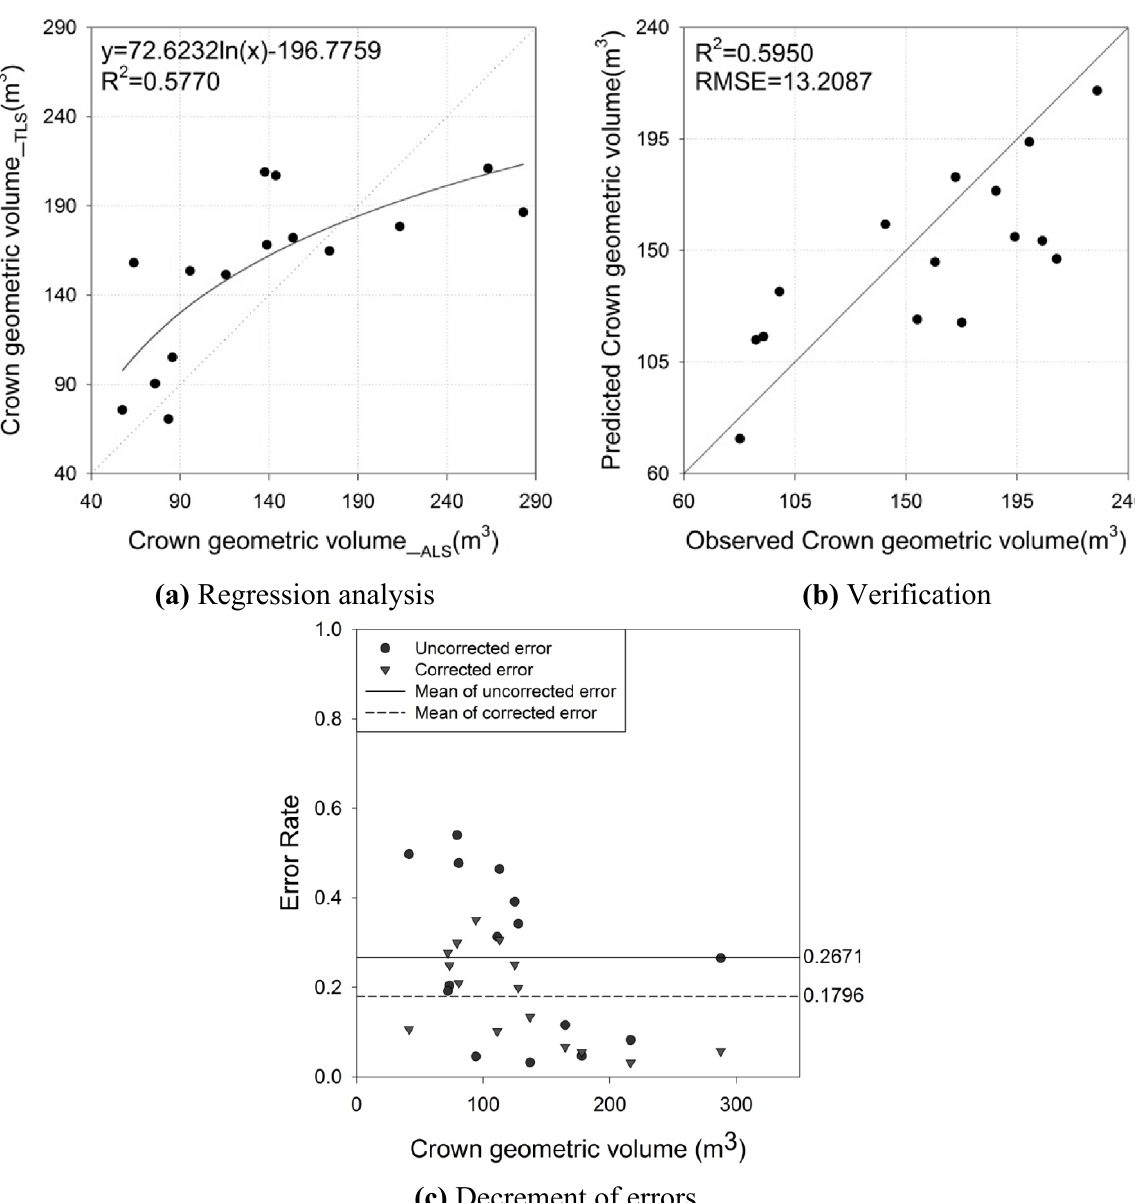
Figure 9. Reduction of CGV-estimate errors through the regression